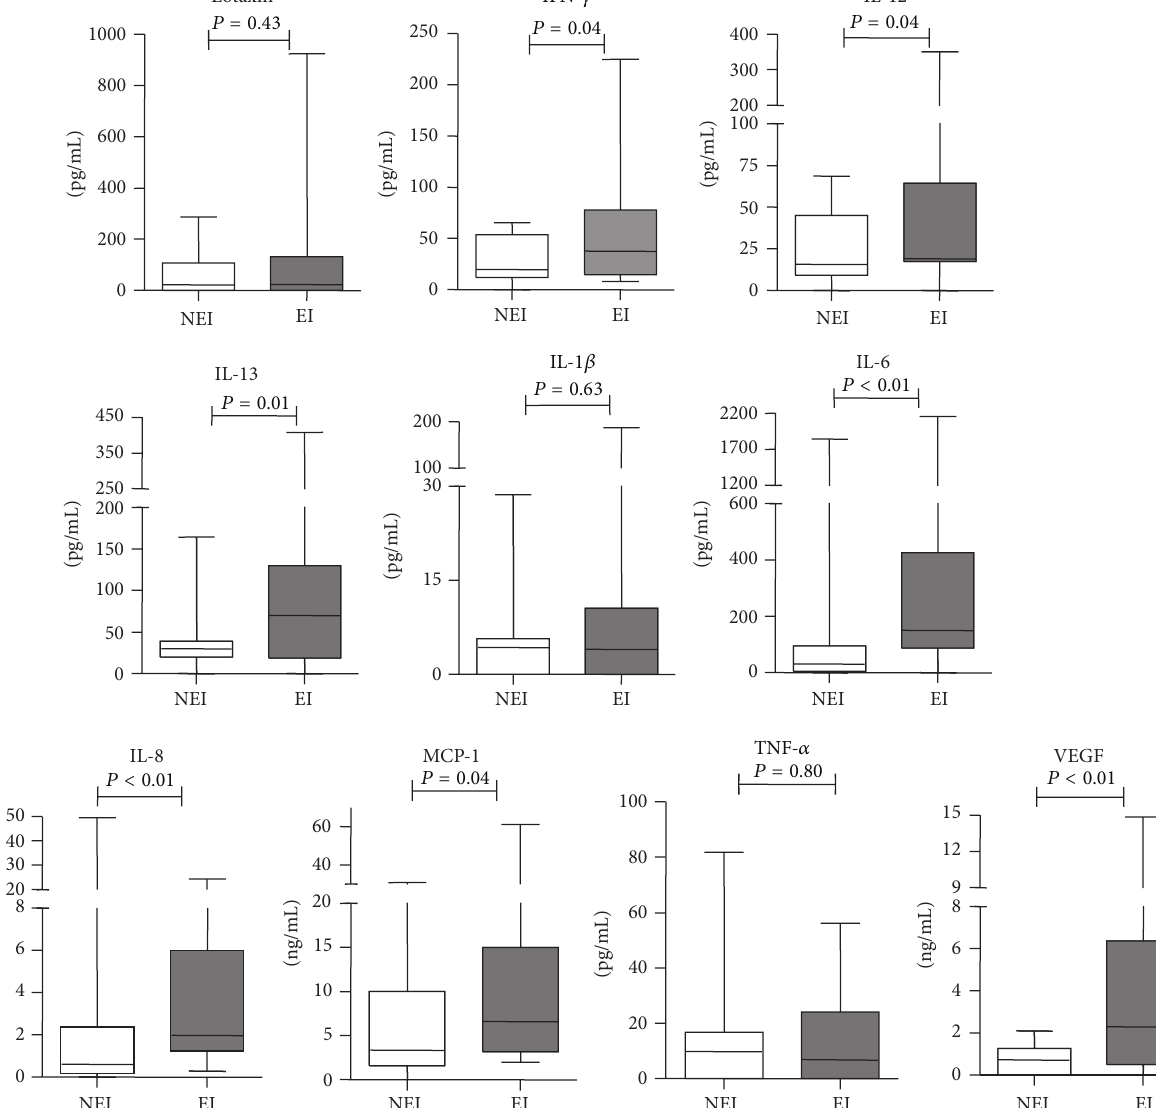
Figure 1: Concentrations of soluble mediators in aspirates of endometrial secretions in the EI and NEI groups. The expression of cytokine profiles [eotaxin, IFN- 𝛾 , IL-1 𝛽 , IL-6, IL-8, IL-12 (p70), IL-13, TNF- 𝛼 , MCP-1, and VEGF] of endometrial secretions obtained before ET from 66 patients (NEI: 28; EI: 38) was analyzed. The box plot horizontal lines represented the median and the 25th–75th percentile. The 𝑃 values obtained are the results of the Mann-Whitney 𝑈